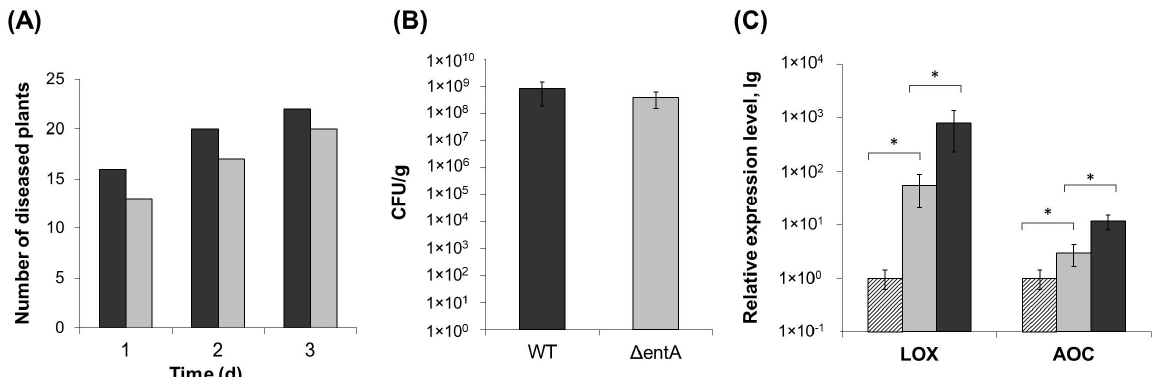
Figure 2. Virulence of ∆ entA mutant of Pectobacterium atrosepticum SCRI1043. ( A ) Number of tobacco plants displaying maceration symptoms after infection with the wild type (dark grey) or ∆ entA mutant (light grey) of P. atrosepticum . ( B ) Bacterial colony forming unit (CFU) titer in the tobacco plants infected with the wild type (dark grey) or ∆ entA mutant (light grey) of P. atrosepticum . ( C ) Expression levels of genes LOX (lipoxygenase) and AOC (allen oxide cyclase) in non-infected plants (hashed column) and infected with the wild type (dark grey) or ∆ entA mutant (light grey) of P. atrosepticum . The expression levels and CFU titers were determined one day post inoculation. The presented values in B and C are means ± SD of five biological replicates. Asterisks (*) show the significance of difference (Mann–Whitney two-sided test, p < 0.05).